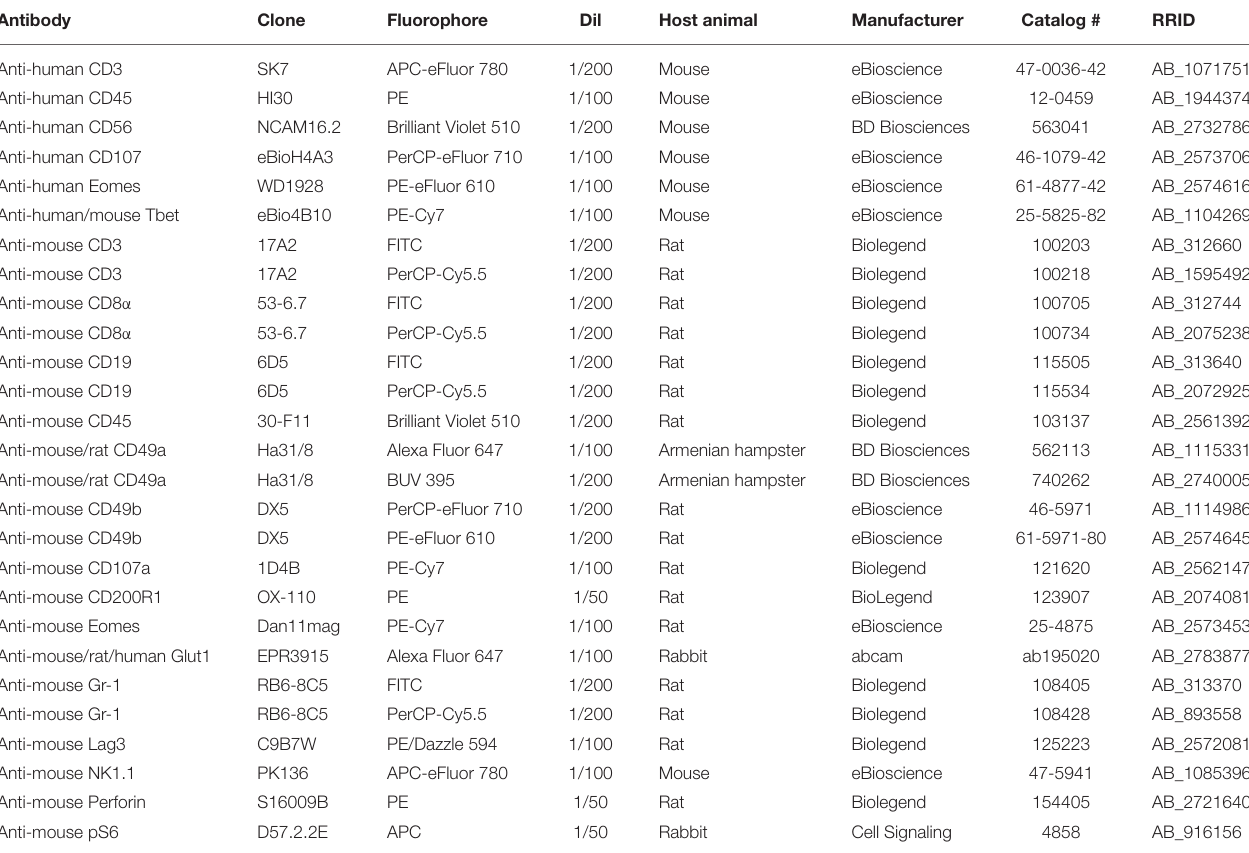
TABLE 1 | Details of antibodies used in the